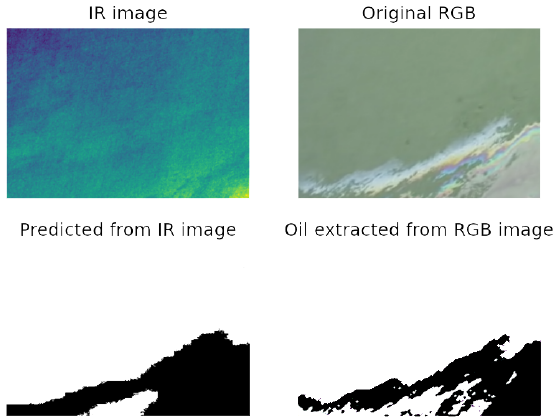
Figure 9. Oil classification result of the neural network (Mobilenet+FCN8+RMSprop). Top : infrared and RGB images. Bottom-right : mask from the RGB image using thresholding (see Section 3.1). Bottom-left : result of the trained neural network when applied to the infrared image ( top-left ). Table 1. Results of the different architectures, feature extractors and optimizers. Note: only the result with the best optimizer is